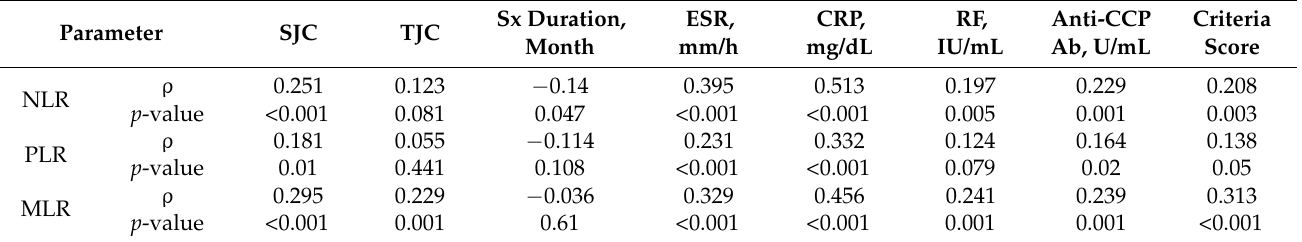
Table 2. Correlation between laboratory and clinical variables in postmenopausal patients with undifferentiated inflammatory arthritis.